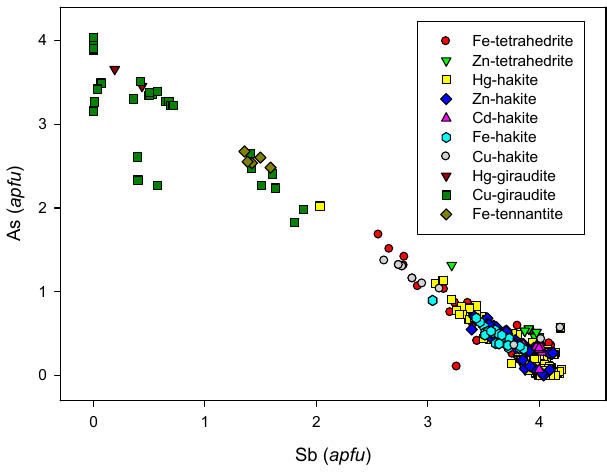
Figure 53. Sb vs. As ( apfu ) graph for tetrahedrite group of minerals from P ř íbram. Fe-tennantite is very rare in the studied